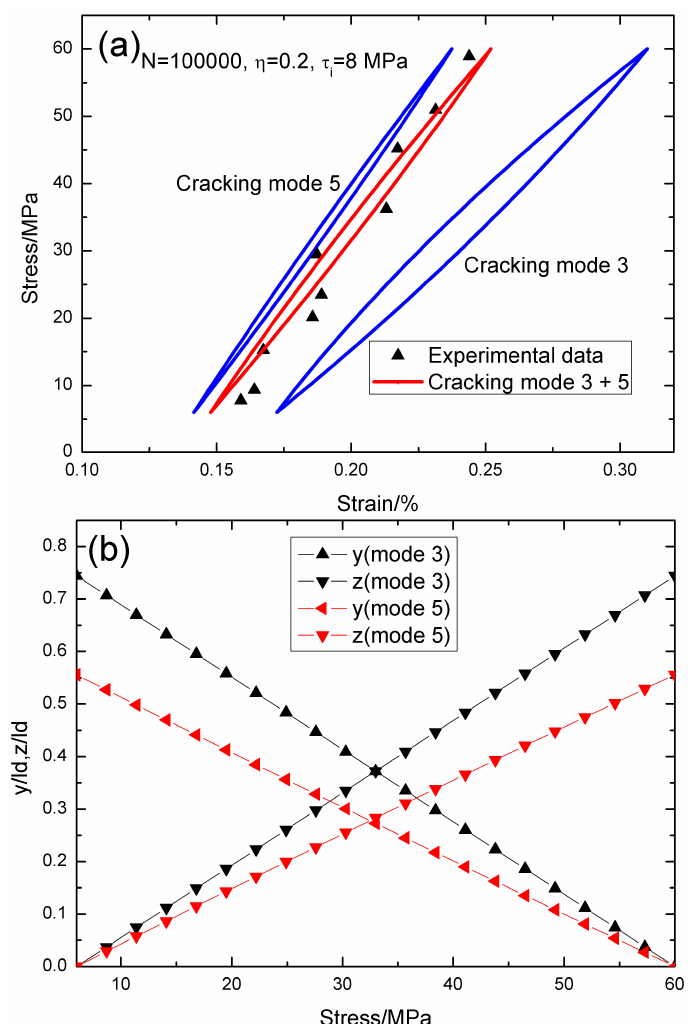
Figure 4. ( a ) The theoretical and experimental hysteresis loops; and ( b ) the interface slip lengths, i.e. , y / l d and z / l d , of matrix cracking modes 3 and 5 of 2D woven SiC/SiC composite under σ max = 60 MPa at 1000 °C in steam and a loading frequency of 1.0 Hz when N =